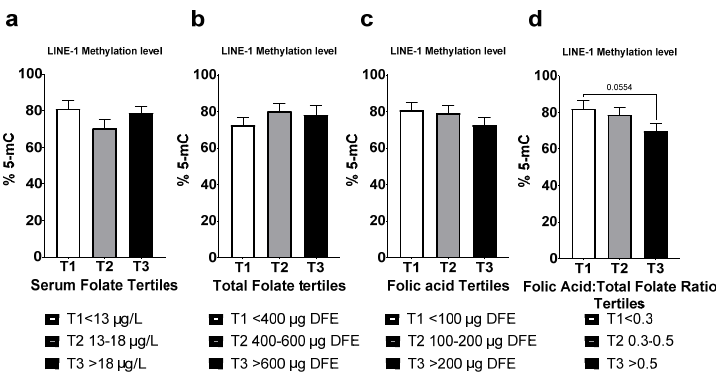
Figure 4. Global LINE-1 methylation levels in human lymphocytes based on: ( a ) serum folate tertiles 1. ( b ) Total dietary folate intake tertiles. ( c ) Dietary folic acid intake tertiles. ( d ) dietary folic acid intake: total folate intake ratio tertiles. Serum folate presented as µ g/L (ng/mL), DFE; (dietary folate equivalent), data presented as mean ( ± SEM), n =